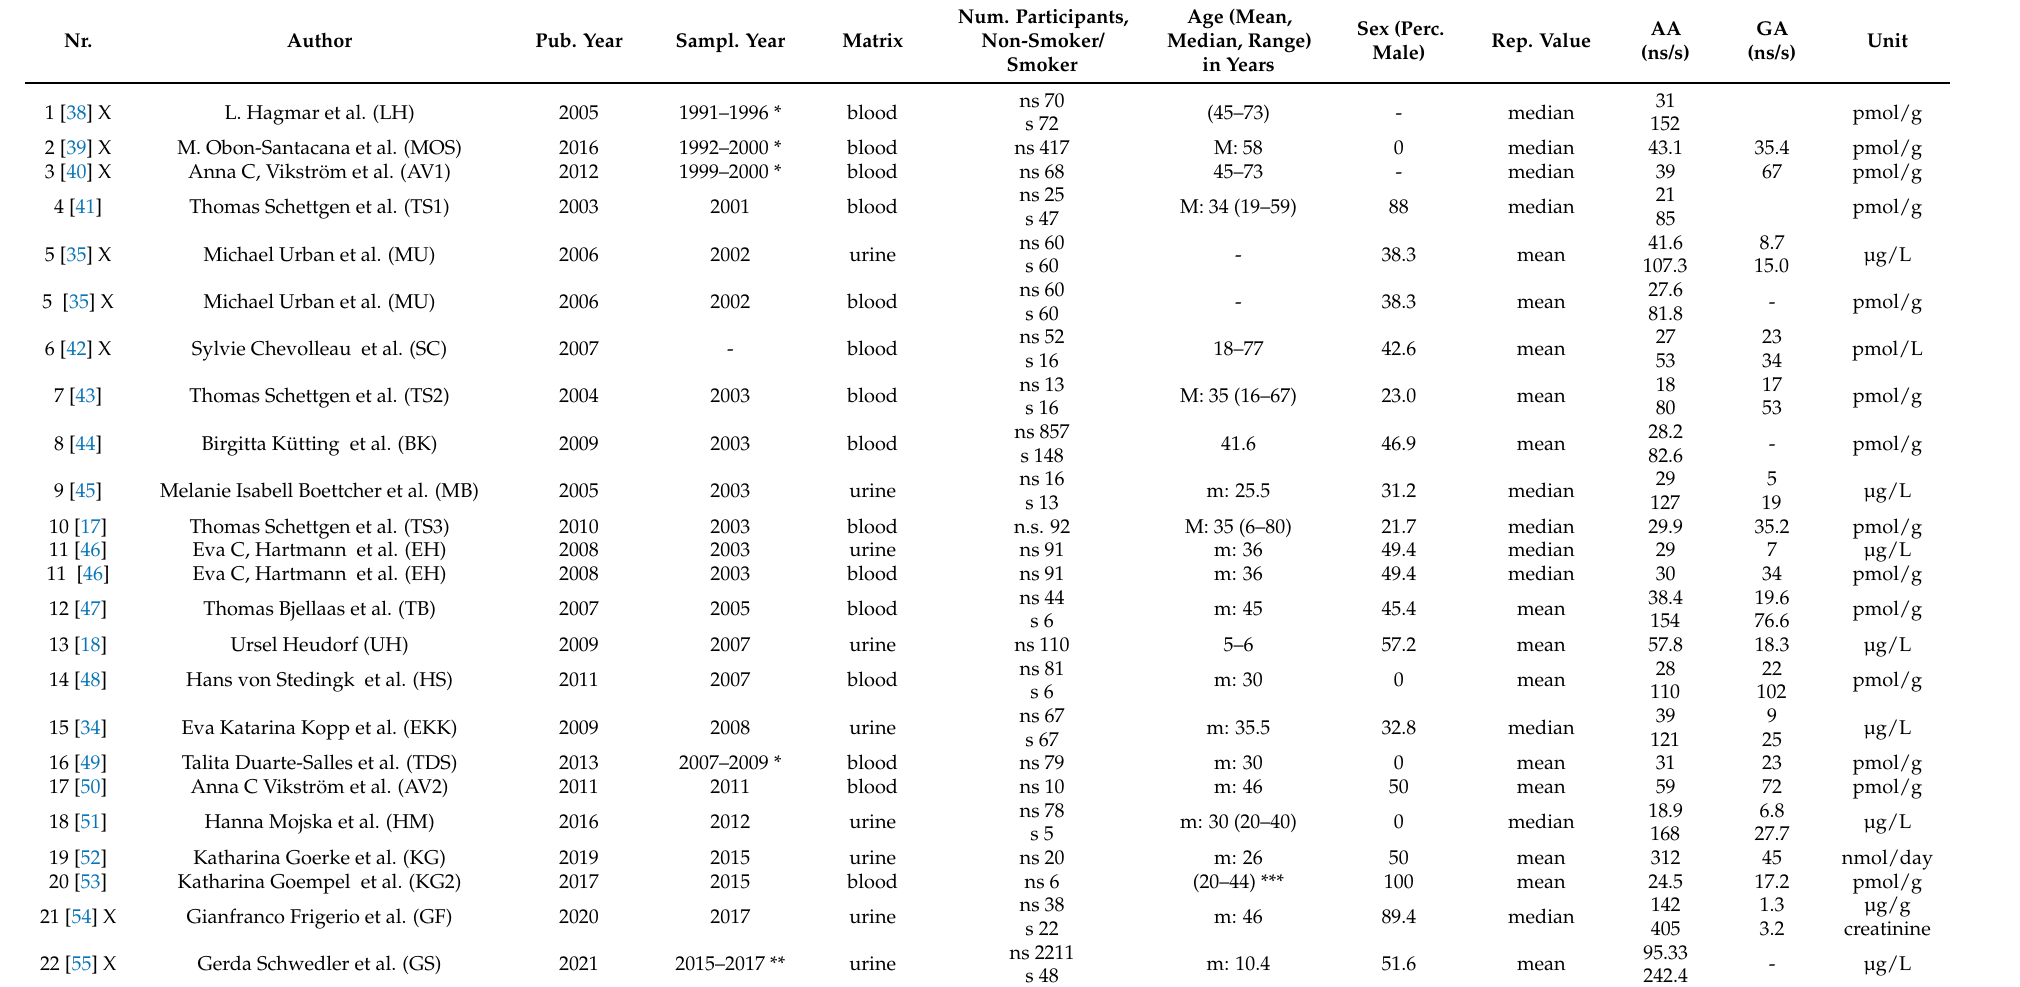
Table 1. Overview of European biomonitoring